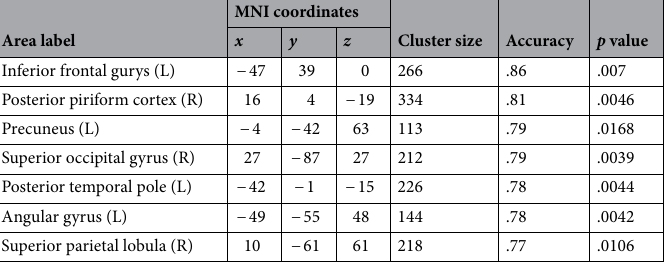
Table 1. List of clusters for tenfold cross validation SVM with classification accuracy for individuals with anosmia and healthy aged-matched controls based on their gray matter volume patterns. p values are based on permutation tests with 5000